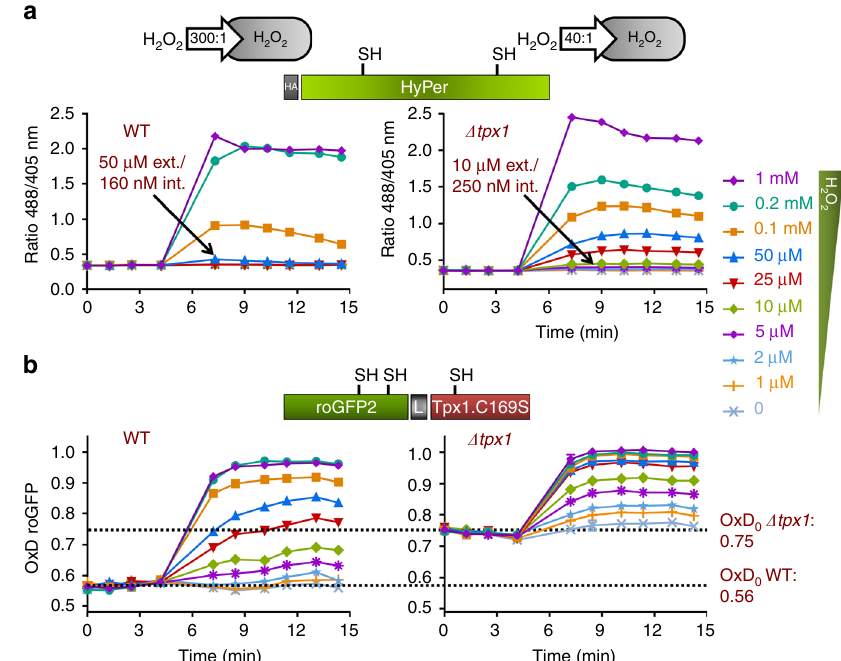
Fig. 3 Basal levels of oxidation, OxD 0 , of roGFP2-Tpx1.C169S are elevated in cells lacking Tpx1. Strains HM123 (WT) and SG5 ( Δ tpx1 ) were transformed with plasmids p605, coding for HyPer ( a ) and p407.C169S, coding for roGFP2-Tpx1.C169S ( b ) and H 2 O 2 treatments were performed and oxidation of the reporters estimated as described in Fig. 1. For each panel, data from three biological replicates are shown, with error bars (S.D.) displayed in Supplementary Fig. 5